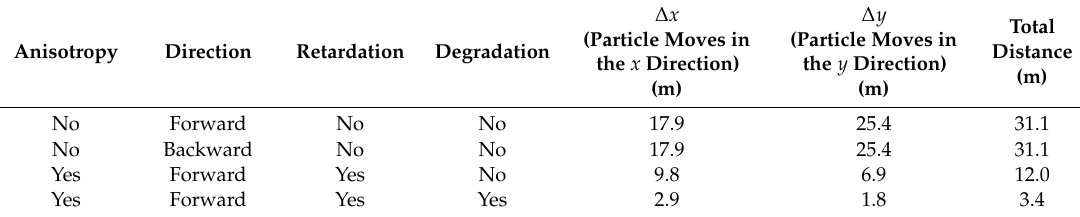
Table 1. The distance particle moved in each scenario at the Pueblo chemical depot in Pueblo,